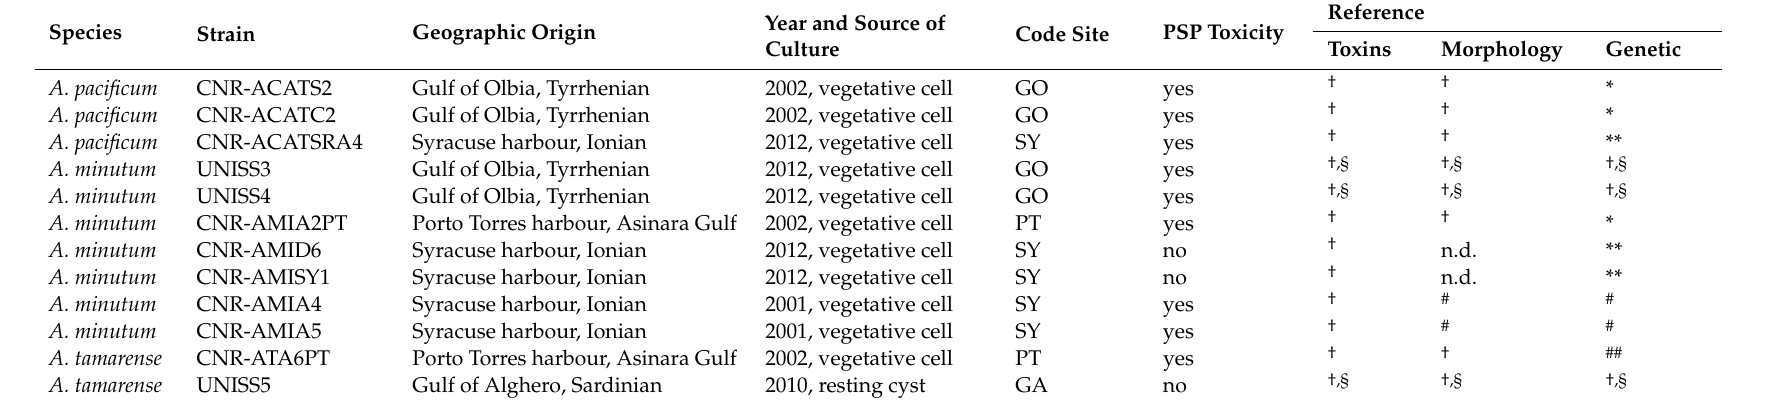
Table 1. List of Alexandrium isolates considered in this study and reference for toxins, morphology and genetic data.